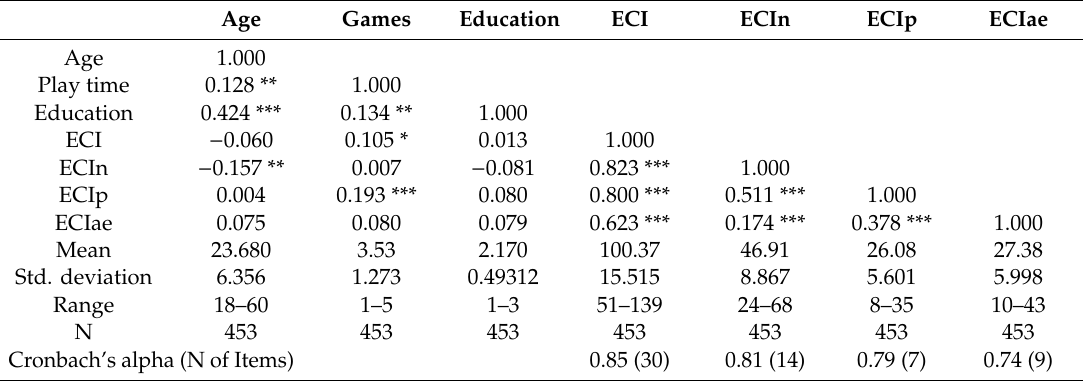
Table 2. Descriptive statistics, reliability, and correlations for all continuous and ordinal